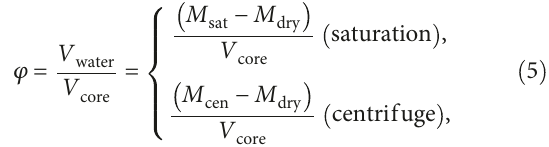
spectra (a) and scatters and the fi tting lines of IWS and FWS 2